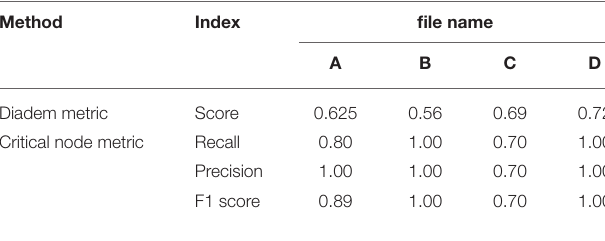
TABLE 4 | PyNeval results of the DIADEM and length metrics for the topological cases are shown in Figures 4A–D